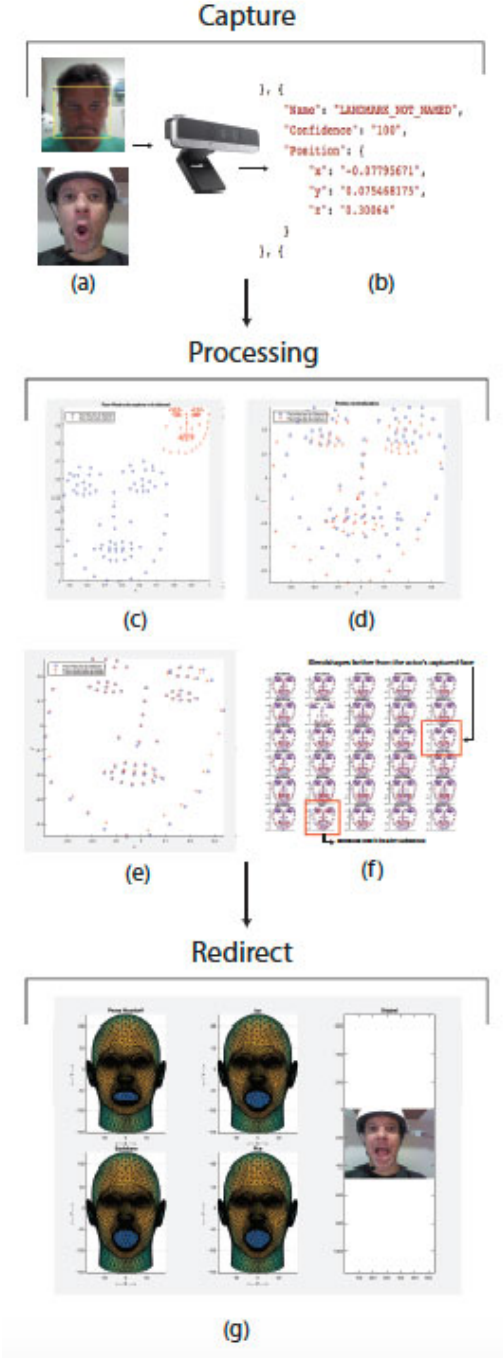
Fig. 4. Pipeline of the capture, processing, and redirection subsystem. (a) frame-by-frame capture of the face of the actor; (b) exported file with 2D and 3D facial marker information; (c) initial adjustment of the neutral face of the actor with the neutral face of the dataset; (d) scale adjustment between faces; (e) translating between the points of the face of the actor and the points of the virtual face; (f) calculation of weights between dataset blendshapes and (g) redirection of weights to the virtual